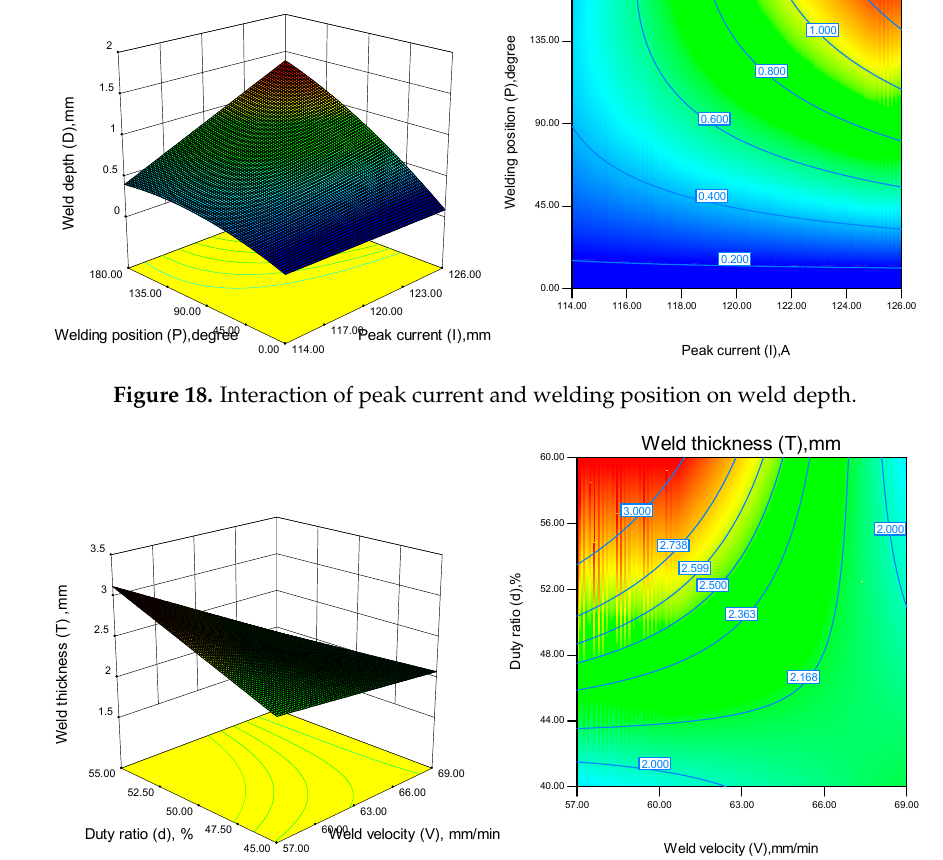
Figure 19. Interaction of weld velocity and duty ratio on weld thickness.